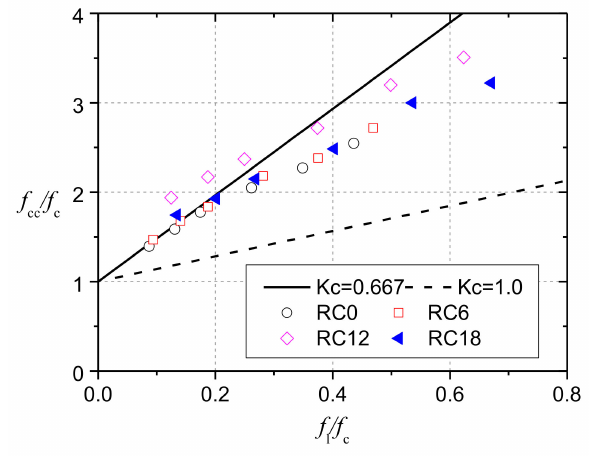
Figure 16. Compressive strength of rubberized concrete under active